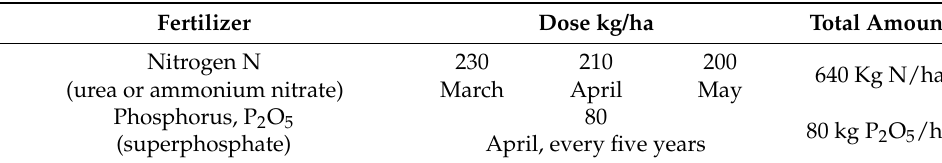
Table 1. Fertilizer applications per year (kg/ha) and time of